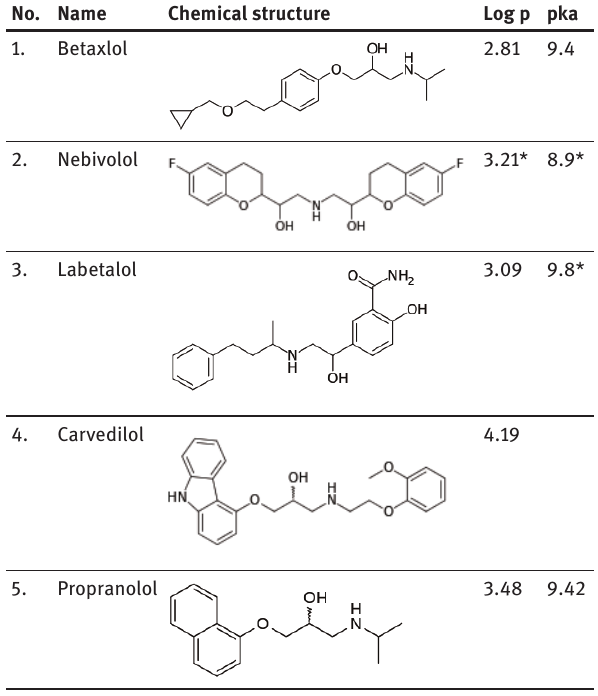
and pk of the studied p a